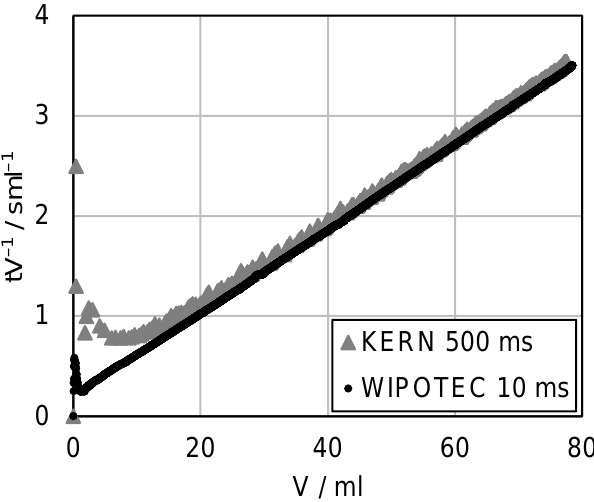
Figure 10. Effects of the balance. Multifilament measured with 25 m% PCC at 0.8 bar.